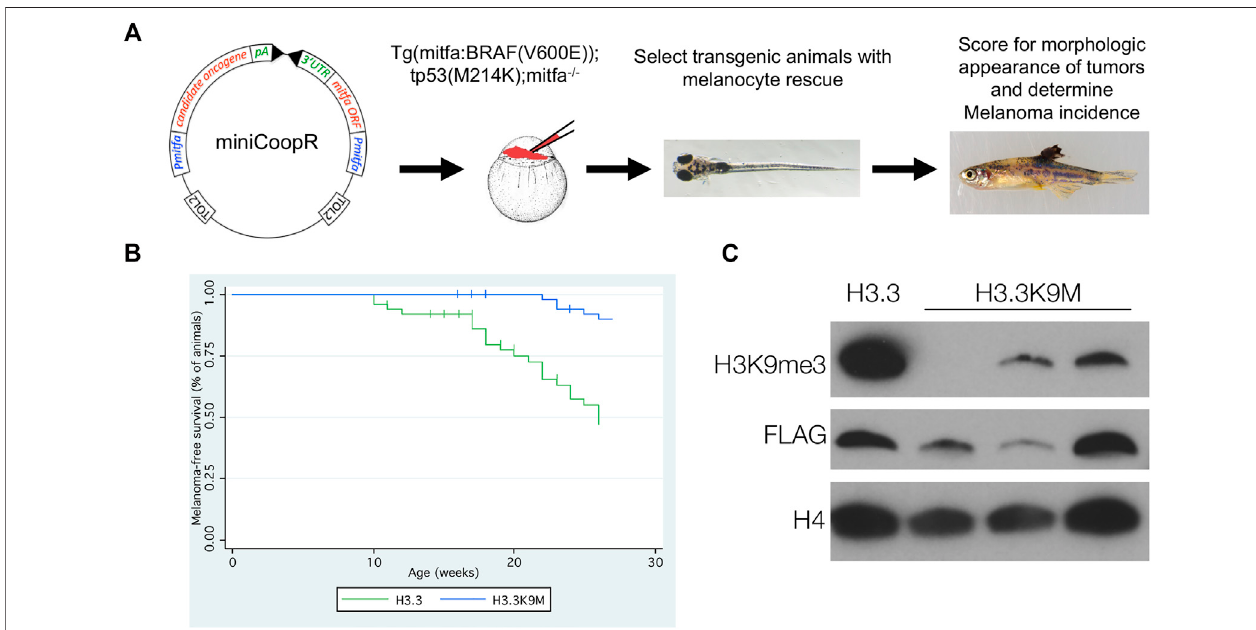
FIGURE 1 | H3.3K9M suppresses melanoma formation. (A) The miniCoopR vector strategy overexpressing candidate genes in a melanocyte-speci fi c fashion. Schematic adapted from Ceol et al. (2011). (B) Kaplan-Meier survival curves of Tg(mitfa:BRAF(V600E)); tp53 zdf1/zdf1 ; mitfa w2/w2 zebra fi sh injected with indicated miniCoopRconstructs( p value=1.81e − 06calculatedfromlog-ranktestbetweenminiCoopRH3.3andH3.3K9M;12miniCoopRH3.3andfourH3.3K9Manimalswere censoredfromthestudy). (C) Westernblotofacid-extractedhistonesfromestablishedtumorsdemonstratesagloballossofH3K9me3. (D) Top1000differentially expressed genes between miniCoopR H3.3 and H3.3K9M (sorted by p -value adjusted). (E) GSEA plots with enriched signatures in H3.3K9M tumors displaying enrichment for interferon responses. (F) Panther gene ontology analysis of the top 250 upregulated gene transcripts by p -value. (G) FishEnrichr analysis of the top 250 upregulated gene transcripts by p -value reveals neutrophil pathways among top 10 GO biological processes (Chen et al., 2013; Kuleshov et al., 2016). H, 16 of 19 transposable elements upregulated in H3.3K9M tumors.